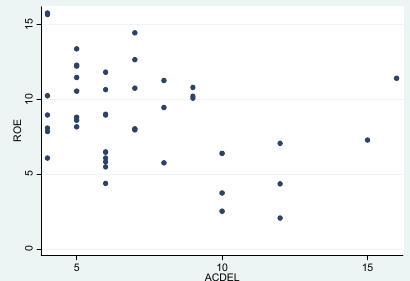
Fig. 5. The results of Pearson correlation between audit committee size and return on equities of Jordanian Banks By analyzing the probability value of the audit committee size ACSIZE of 0.0000 below 0.05, it was concluded that by adjusting